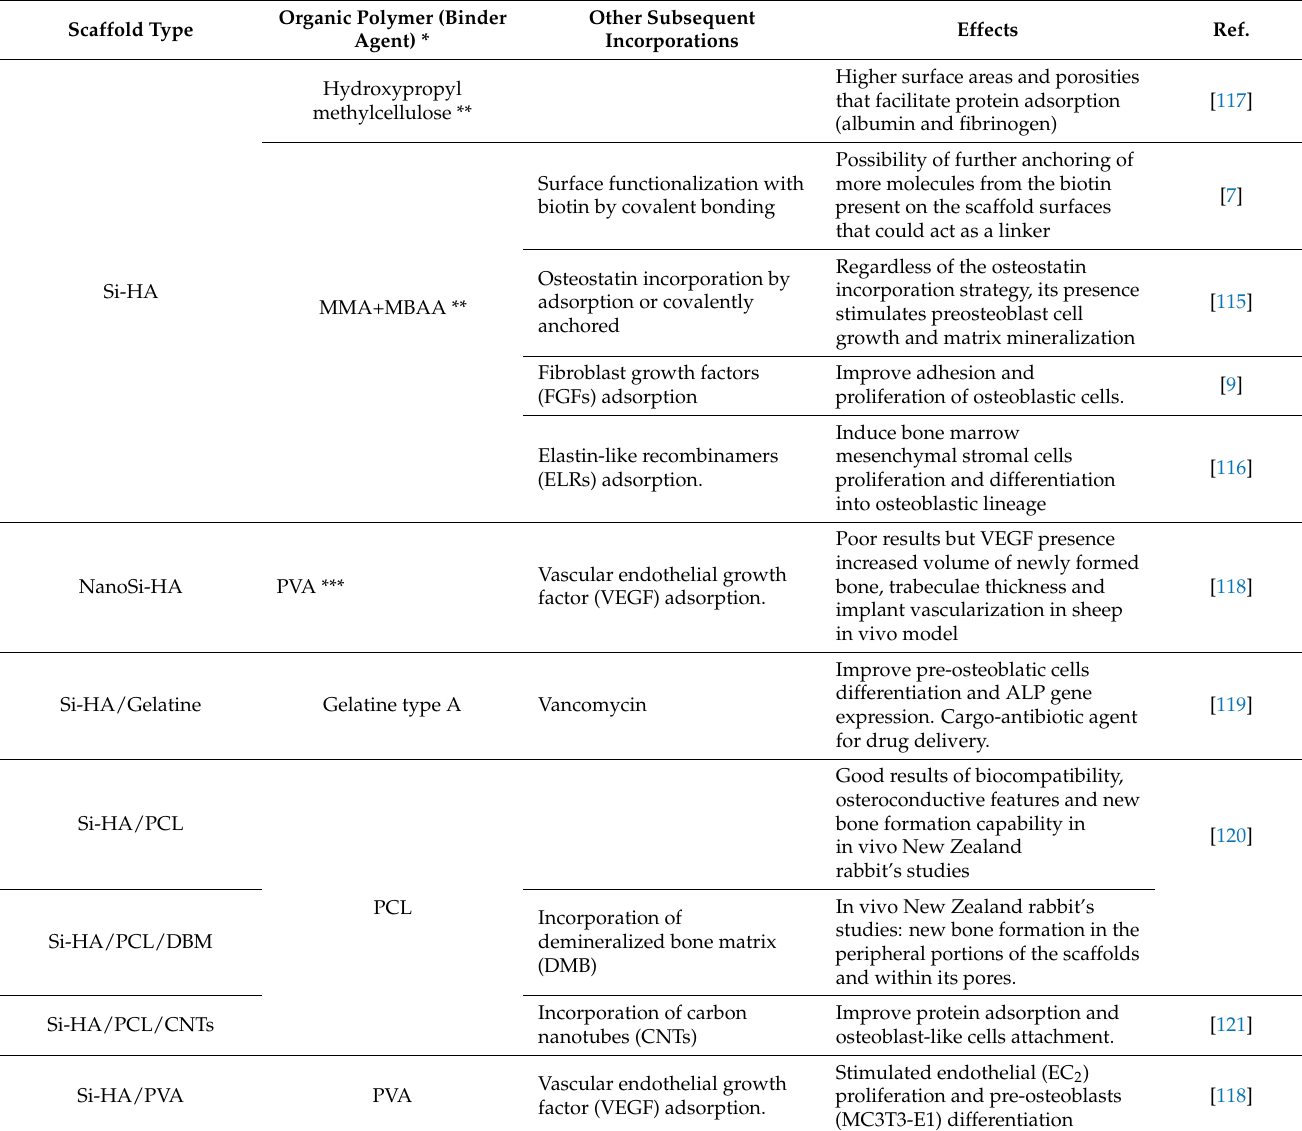
Table 1. 3D scaffolds formed by the ceramic matrix of Si-HA and manufactured by the rapid prototyping method. Scaffold